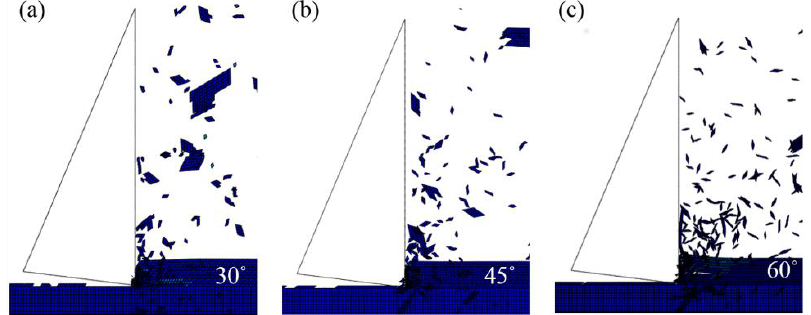
Figure 5. Material responses to the cutting tool with different tile angles: ( a ) 30 degrees, ( b ) 45 degrees, and ( c ) 60 degrees.